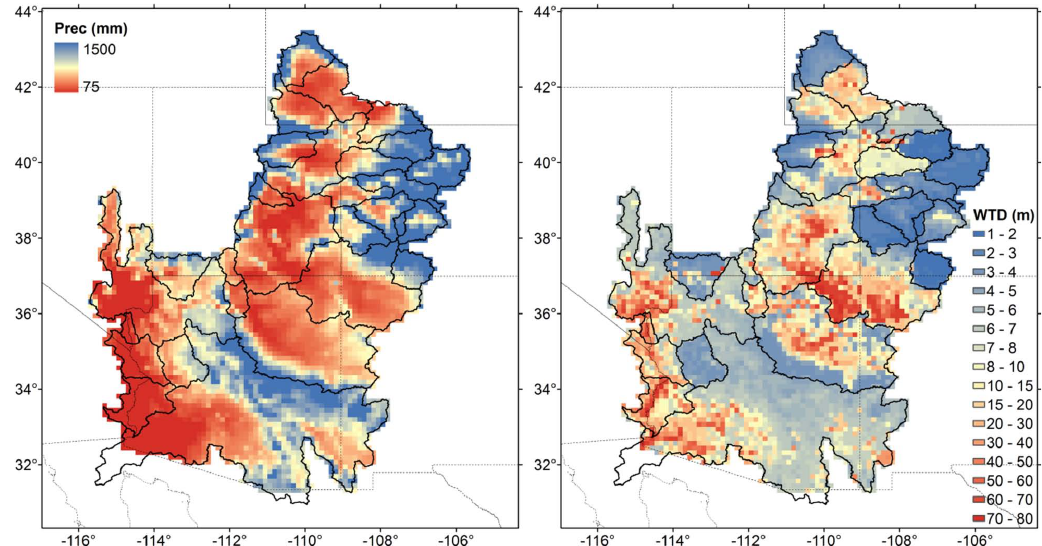
Fig. 2. Average annual precipitation over water years 1950–2008 (left) and equilibrium water table depth as simulated by SIMGM